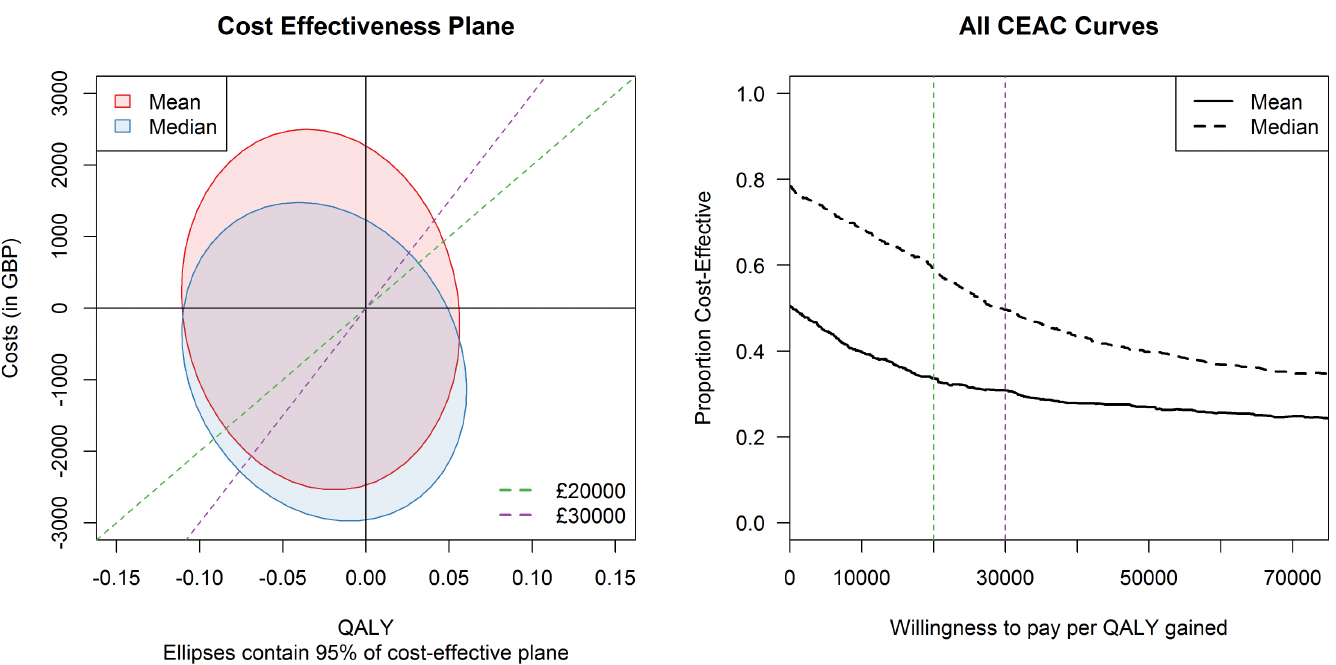
Fig 1. Cost effectiveness plane and CEAC for the intervention. The lines on the cost-effectiveness plane (left) represent willingness-to-pay thresholds of £20,000 (green) and £30,000 (purple). The same willingness to pay thresholds are marked with vertical dotted lines on the CEAC (right). The ellipses represent the area in which 95% of the bootstrap sample values